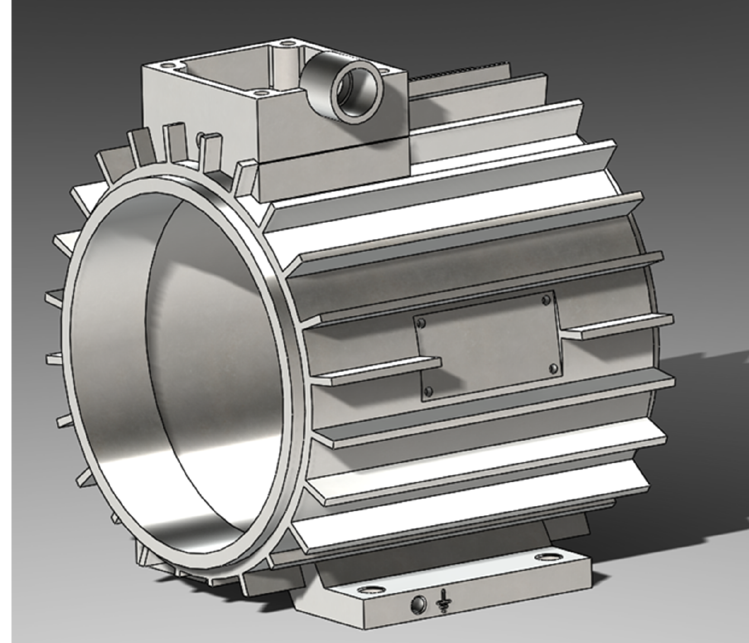
Figure 3. SolidWorks. Induction motor enclosure.